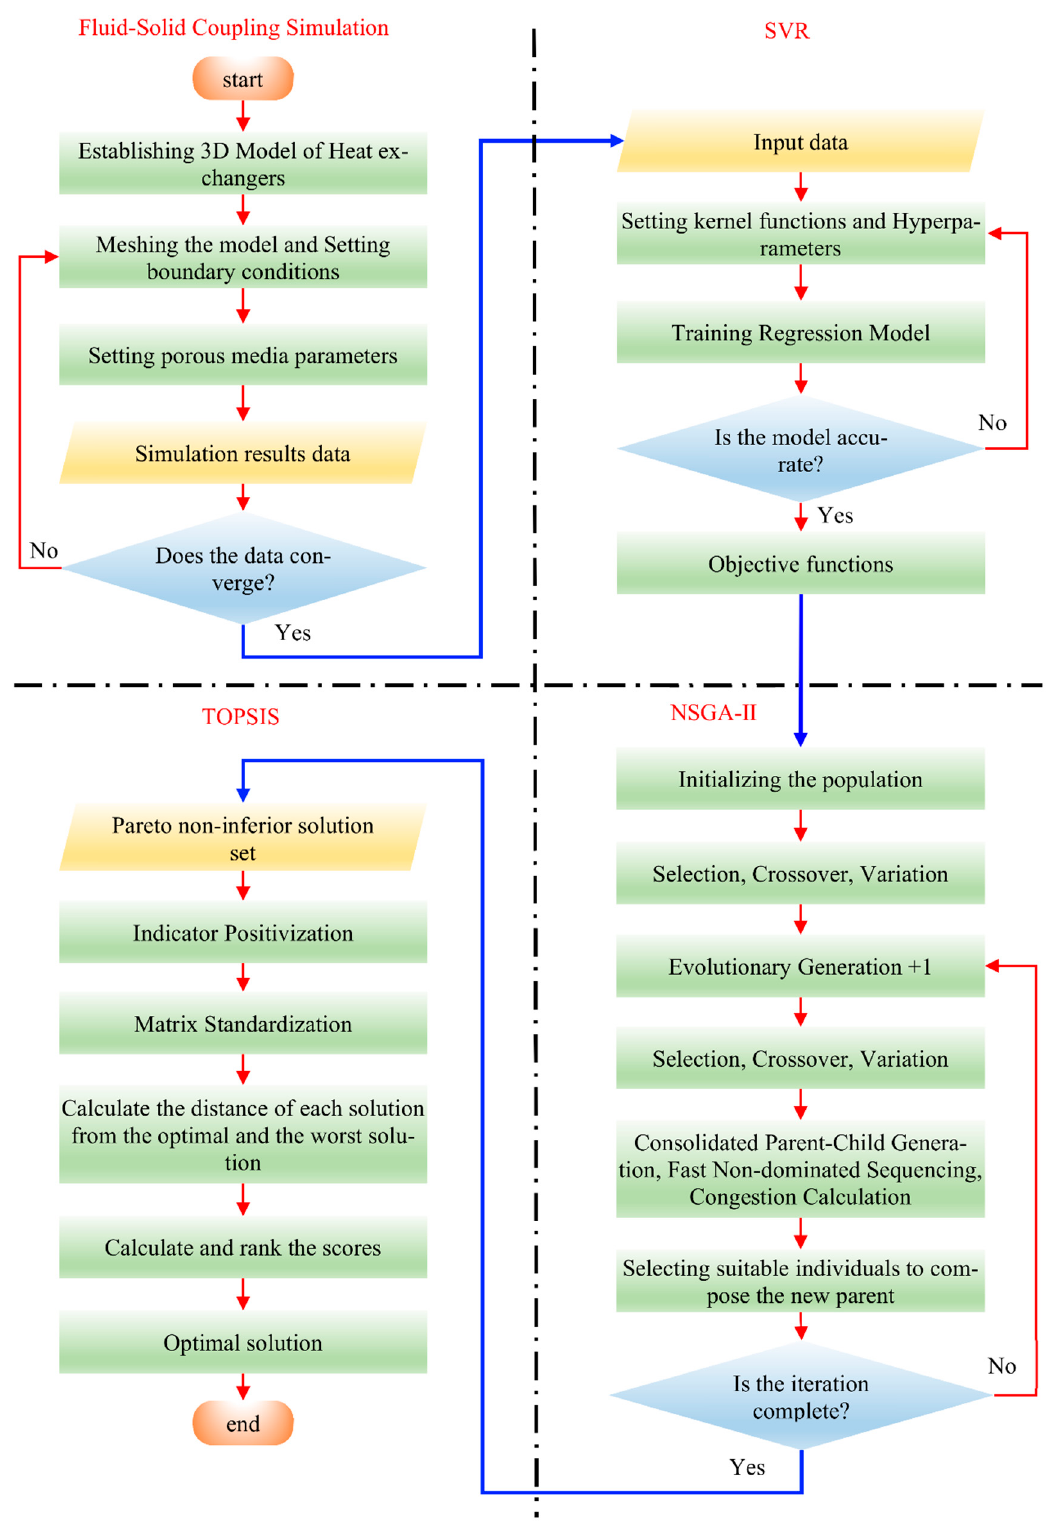
Figure 5. Flow chart of fluid-solid coupling simulation, SVR prediction model, and multi-objective optimization.